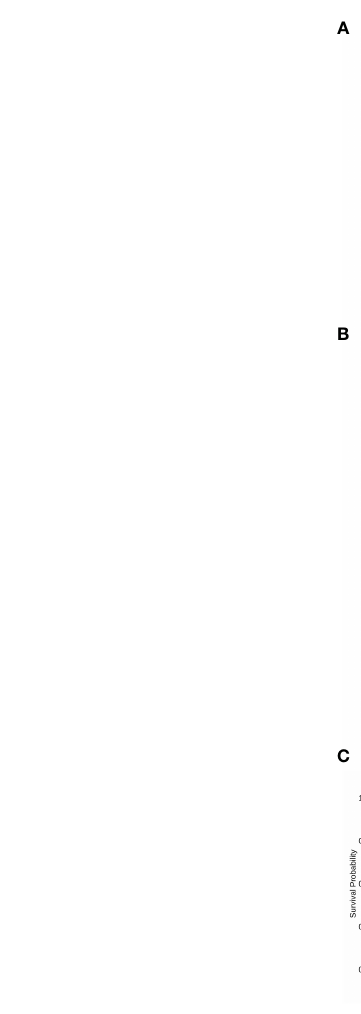
FIGURE 4 Validation of hub LMRG genes. (A) Histological data of AKR1C1, CYP27A1, CYP2C9, GLB1, HMGCS2, and PLPP1 from the Human Protein Atlas. (B) Western blotting analysis of GLB1 and CYP27A1. (C) Kaplan-Meier curves of the risk model in the training cohort. (D) Kaplan-Meier curves of the risk model in the testing cohort. Training cohort: TCGA-LIHC; testing cohort: ICGC-LIRI-JP.